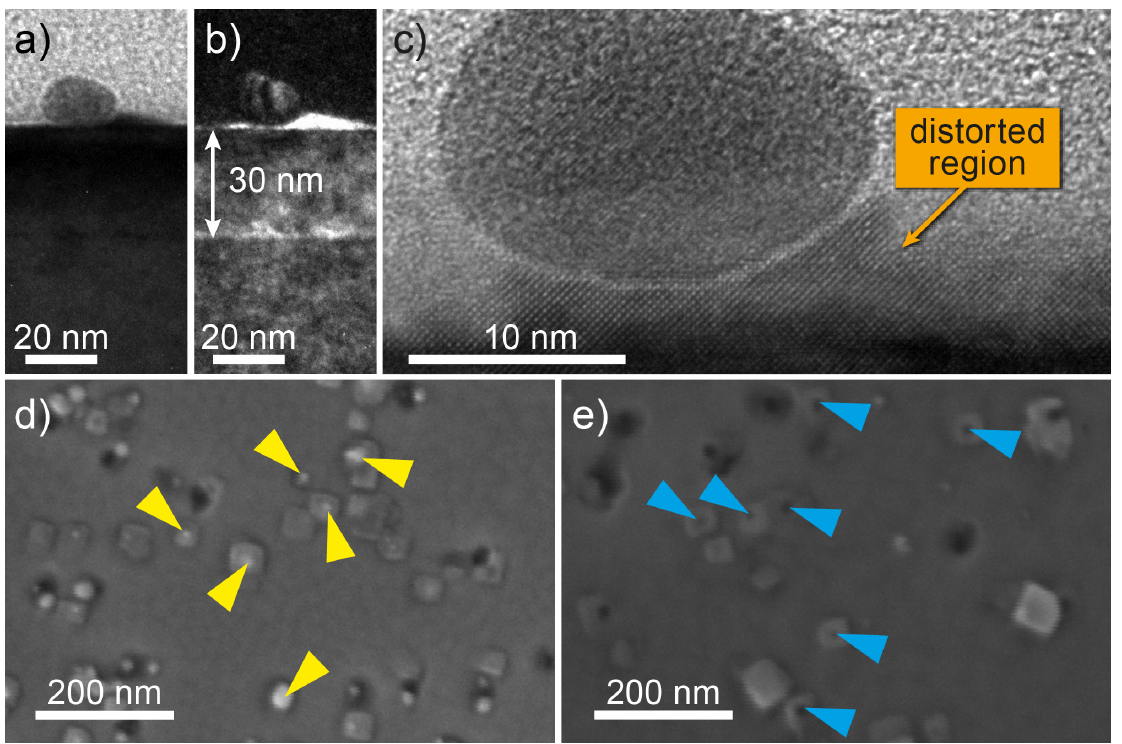
Figure 2. ( a ) Bright-field and ( b ) dark-field TEM image of a low density AuNP SrTiO 3 sample in the vicinity of a AuNP. ( c ) TEM image of a AuNP with a distorted SrTiO 3 region next to and underneath it. ( d ) SEM image of a sample with medium AuNP density after SrTiO 3 deposition. The bright spots indicated by yellow arrows are assigned to AuNPs. ( e ) SEM image of a sample with medium AuNP density after etching with iodine-potassium iodide solution. The dark spots marked by blue arrows indicate holes in the SrTiO 3 thin